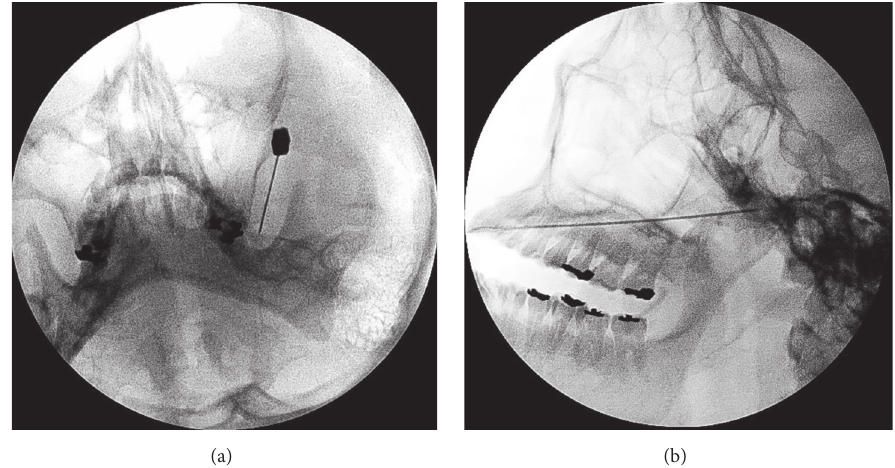
Figure 2: Fluoroscopy-guided diagnostic block of the left mandibular nerve. Anteroposterior (a) and lateral (b) views show the needle tip directed toward the left foramen